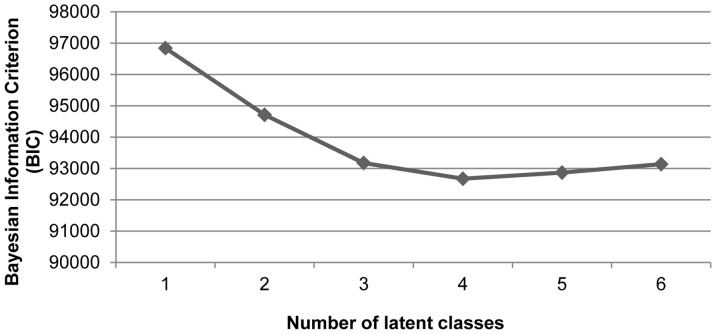
The value of the Bayesian Information Criterion for one to six latent classes.